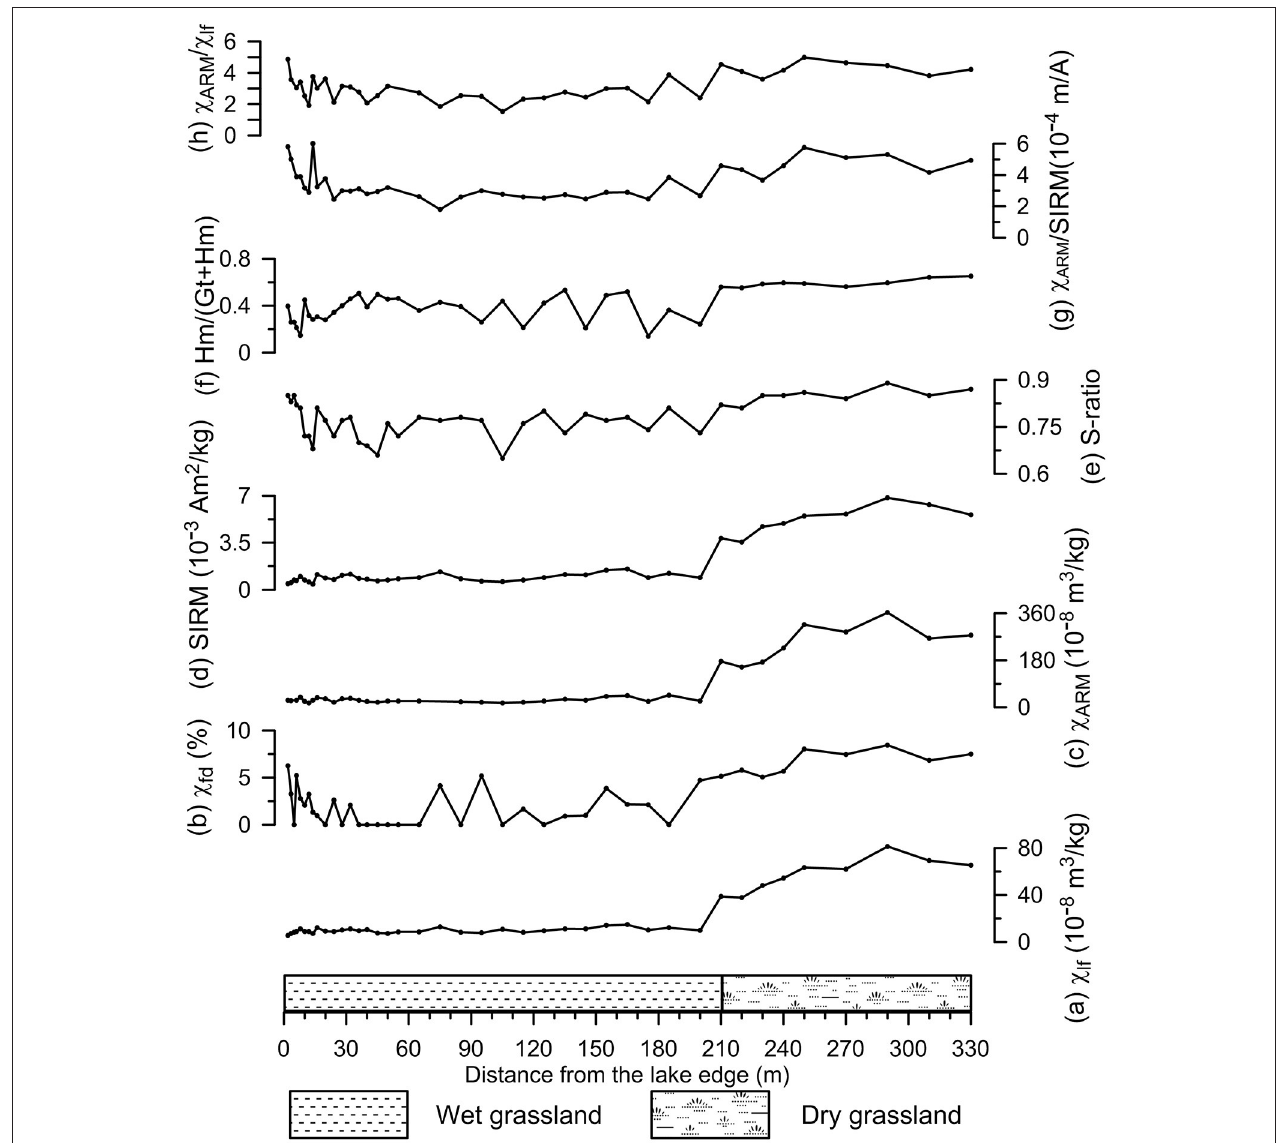
FIGURE 7 | Variations of environmental magnetic parameters vs. depth. (A) low field magnetic susceptibility ( χ lf ), (B) percentage of frequency dependent susceptibility ( χ fd ), (C) susceptibility of the anhysteretic remanent ( χ ARM ), (D) saturation isothermal remanent magnetization (SIRM), (E) S-ratio, (F) the value of hematite/(goethite + hematite), (G) χ ARM /SIRM, (H) χ ARM / χ lf